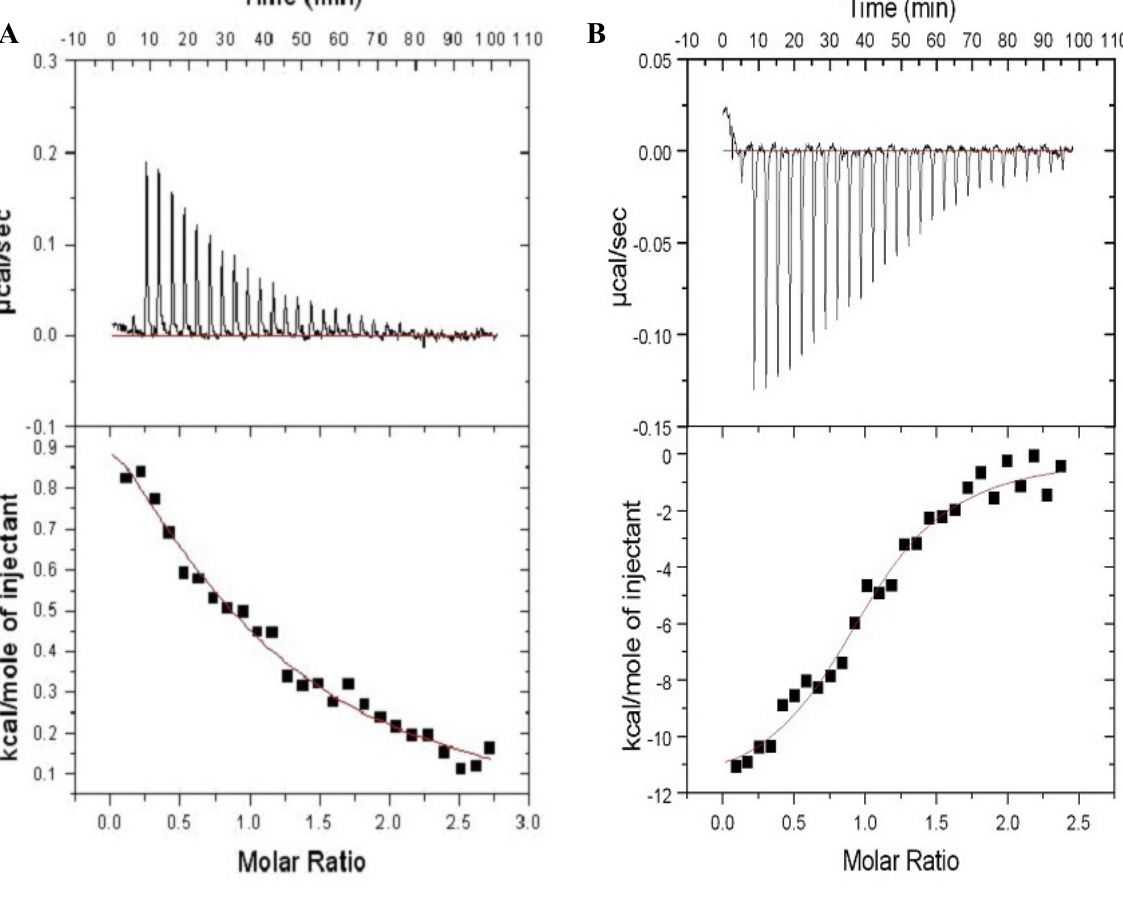
Figure 3. Isothermal Titration Calorimetry of ( A ) 70 μ M HVR peptide with 1 mM CaM, and ( B ) 2.9 μ M FM-HVR peptide with 33 μ M CaM. The upper panels in ( A ) and ( B )